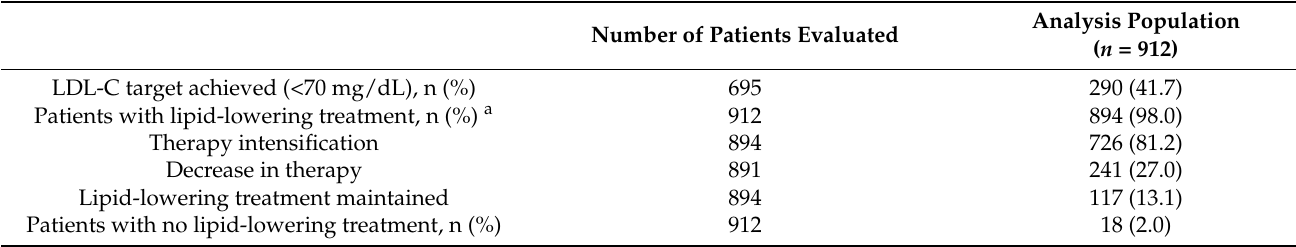
Table 5. Primary endpoints: achievement of target LDL-C <70 mg/dL and changes in lipid-lowering